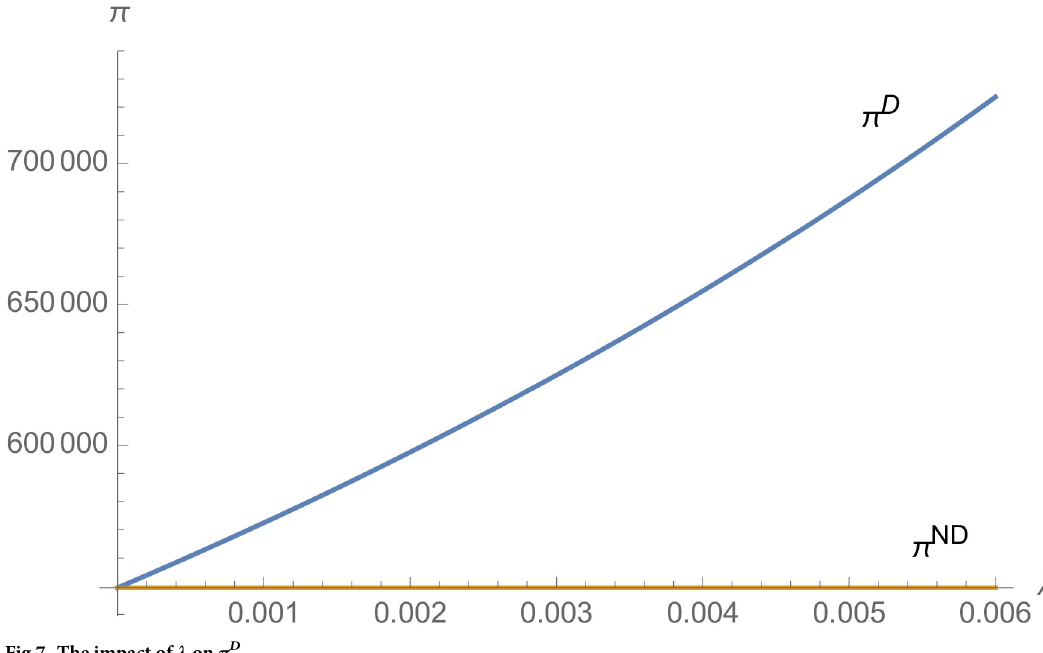
Fig 7. The impact of λ on π D .